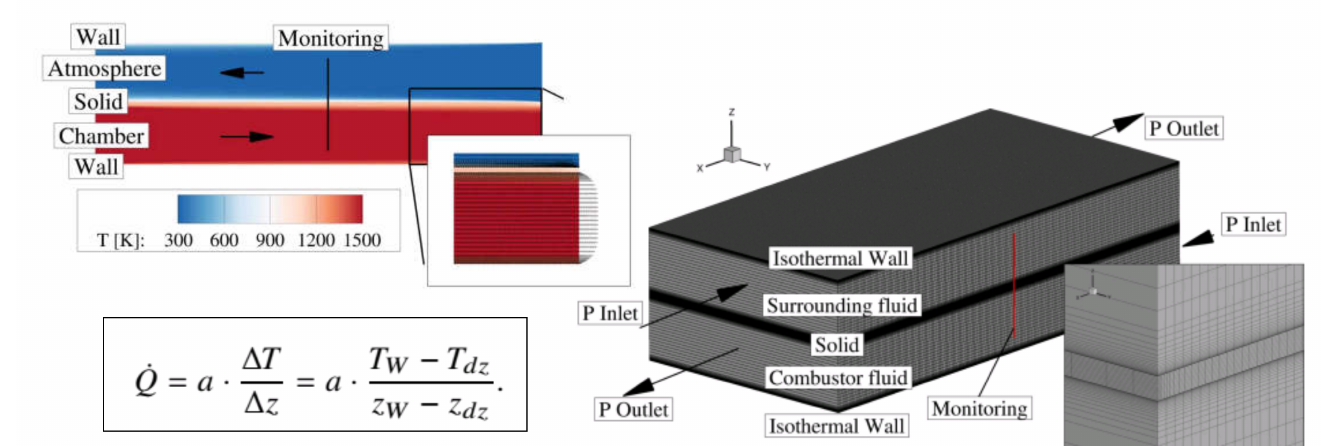
Figure 4. CHT (Conjugated Heat Transfer) numerical setup for the evaluation of heat transfer coefficients for heat-flux boundary prescription. Emulation of a cutout of near-wall conditions in the actual combustion chamber. P: Pressure boundary conditions. Adapted from [48]. z : Wall normal distance in the given ccordiante system. a : Thermal